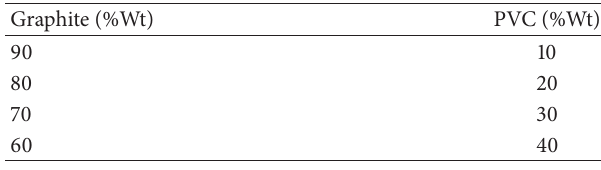
Figure 2: High voltage test circuit used to apply high voltage impulses to polymer thick film resistors (1 to 100 microseconds).